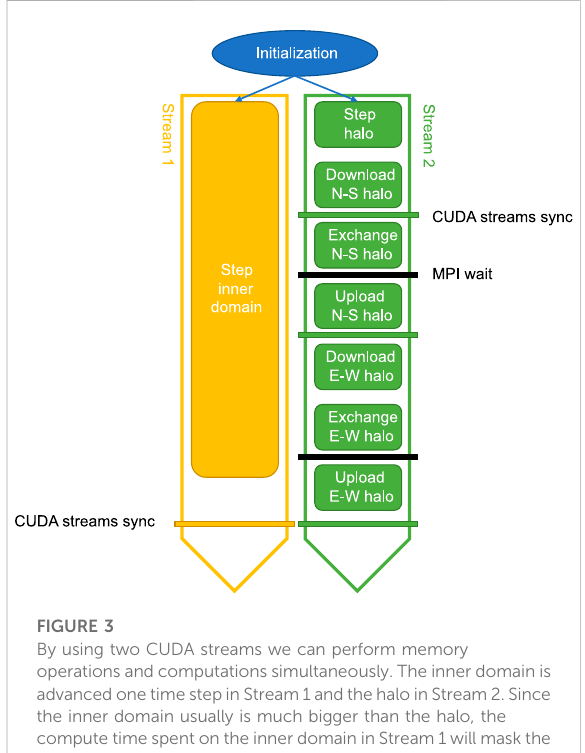
FIGURE 3 By using two CUDA streams we can perform memory operations and computations simultaneously. The inner domain is advancedonetimestepinStream1andthehaloinStream2.Since the inner domain usually is much bigger than the halo, the compute time spent on the inner domain in Stream 1 will mask the time used for exchanging halo regions with neighboring subdomains in Stream 2, including downloading (GPU to CPU), send/receive with MPI, and uploading (CPU to GPU). The step stage executes the same kernel for both streams, shown in Figure 1, but for different areas of the